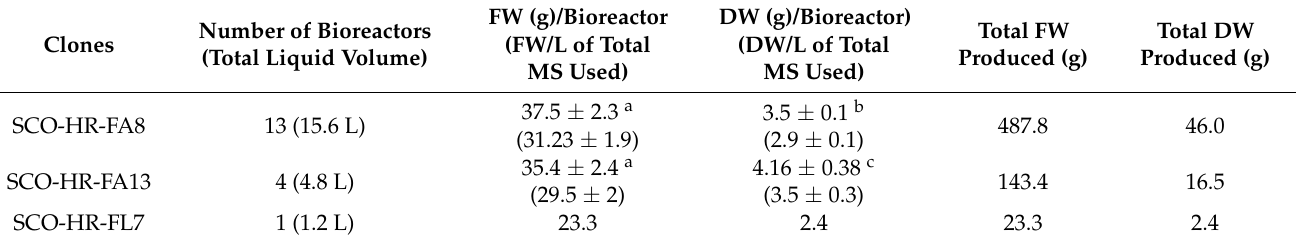
Table 2. Biomass production in bioreactor a .